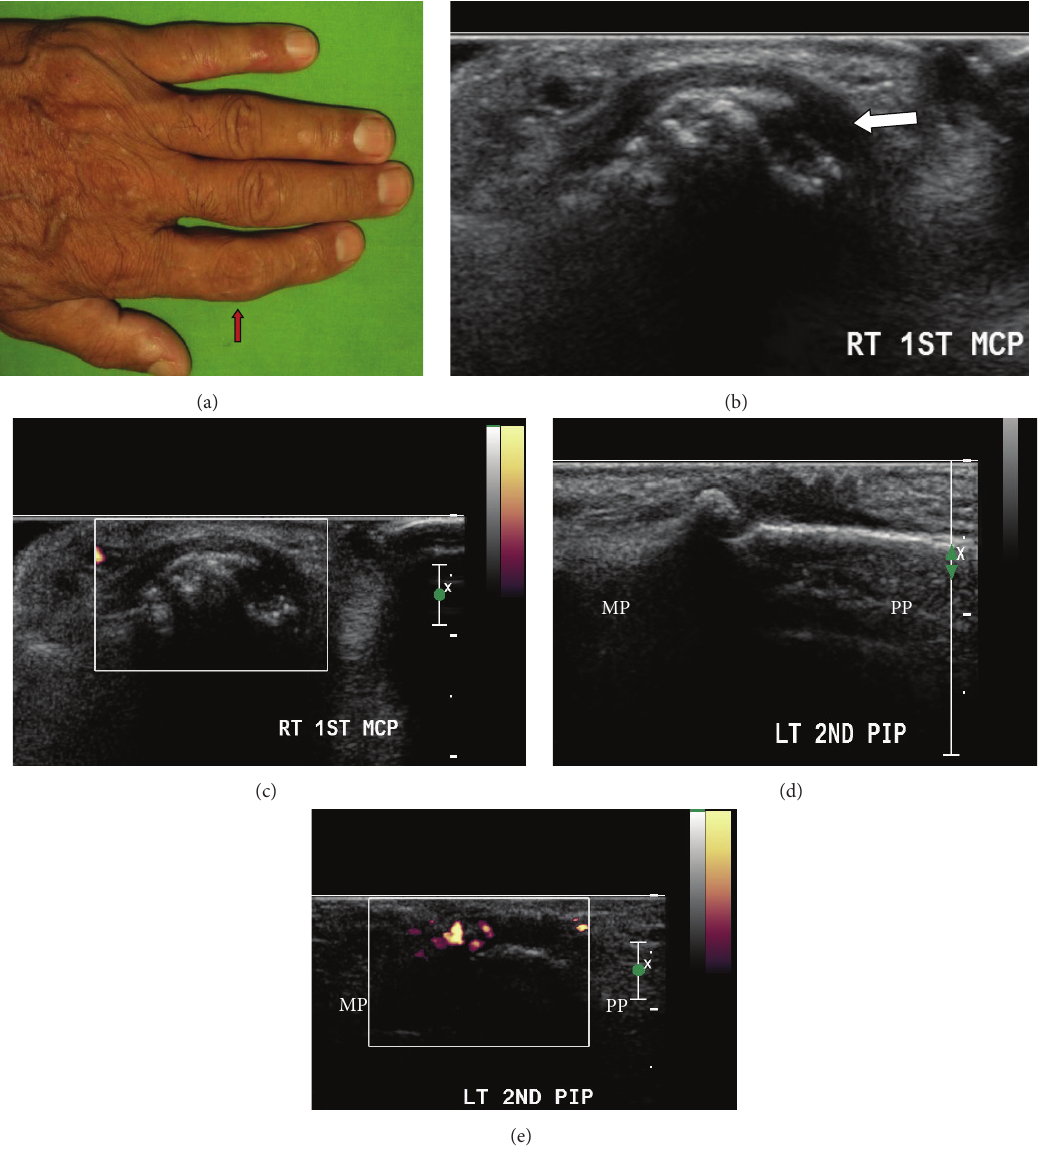
Figure 3: A 52-year-old male patient with PsA presented with pain in multiple joints of the hands in addition to other joints with swelling in left second PIP joint (a, arrow). DAS28 score was 4.78 (suggestive of moderate disease activity) at the time of presentation. US revealed extensive disease in multiple joints of the hands. The GS and PD scores were as follows: GSJC-12, GSJS-18, PDJC-4, and PDJS-8. Grade 2 GS synovial score with Grade 0 PD score in right first MCP joint (b and c). Grade 2 GS score with Grade 2 PD in left second PIP joint (d and e). Longitudinal view (d and e). Transverse view (b and